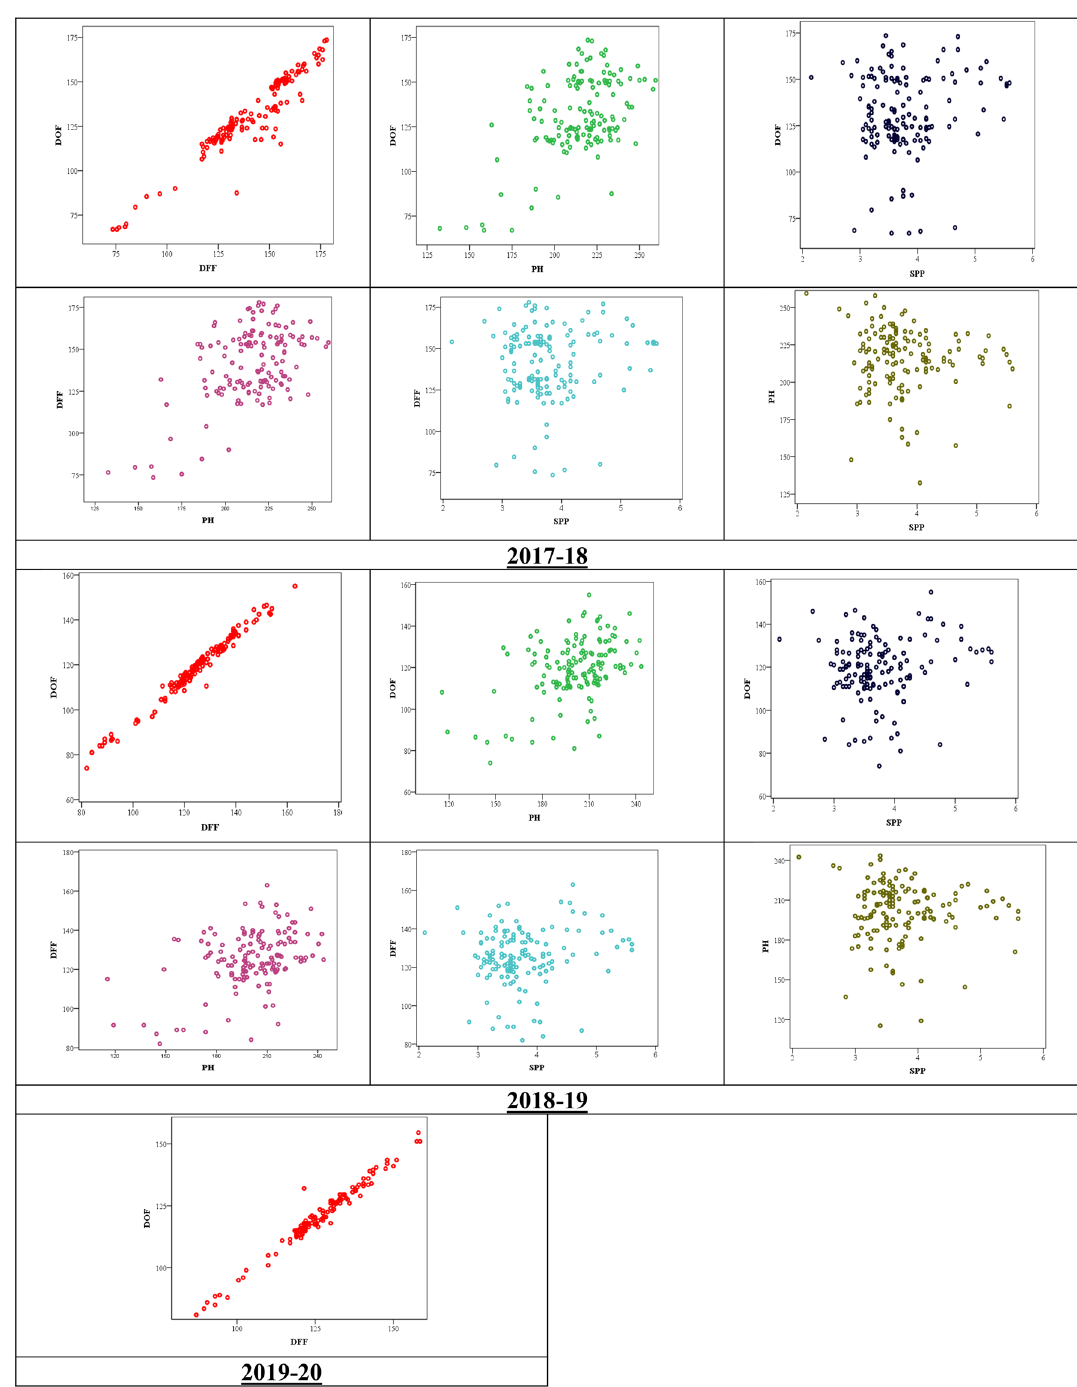
Figure 1. Scatter diagrams showing collinearity among the selected phenotypic traits for different years. Upward linear pattern indicates greater extent of positive correlation. Days to first flowering (DOF), days to fifty percent flowering (DFF), plant height (PH) and average number of seeds/pod